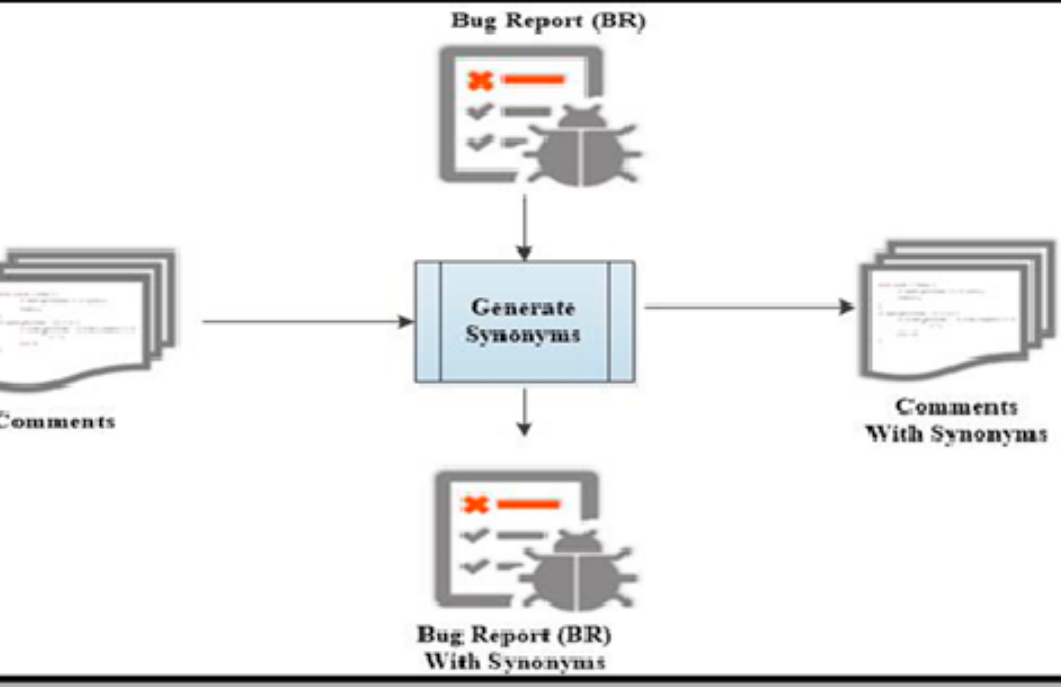
Figure 10. The process of generating synonyms.